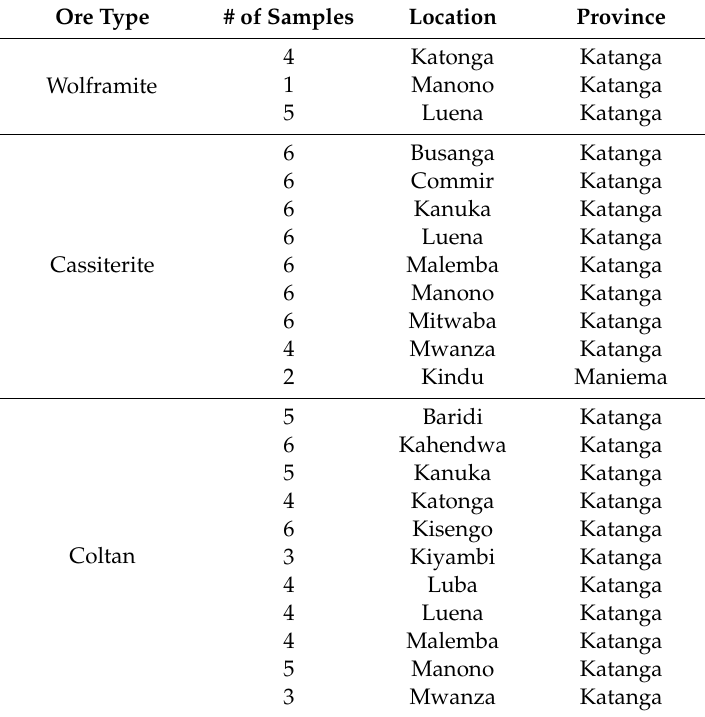
Table 2. Samples used in the study. Locations are shown in Figure